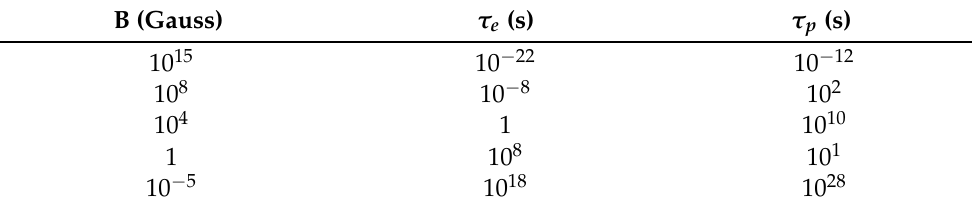
Table 2. Energy decay times of electrons ( τ e ) and protons ( τ p ) orbiting a black hole immersed in a uniform magnetic field with values of B characteristic for various astrophysical